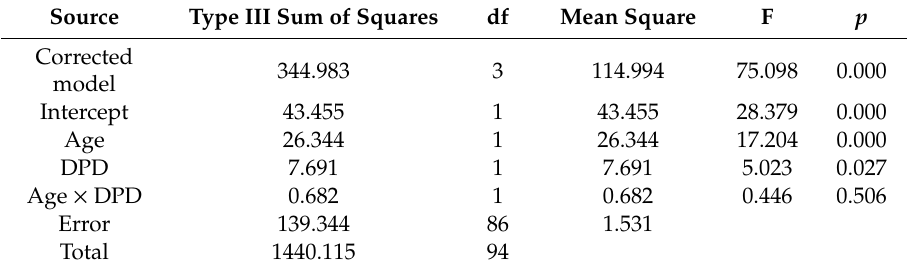
Table 3. Multiple regression analysis with interaction term (adjusted R 2 =